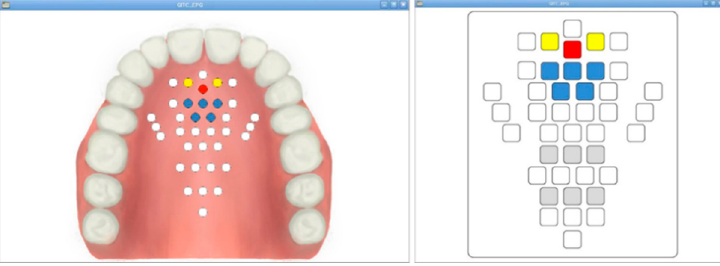
Figure 5. The fabricated monitoring program: the anatomical type and classic type.